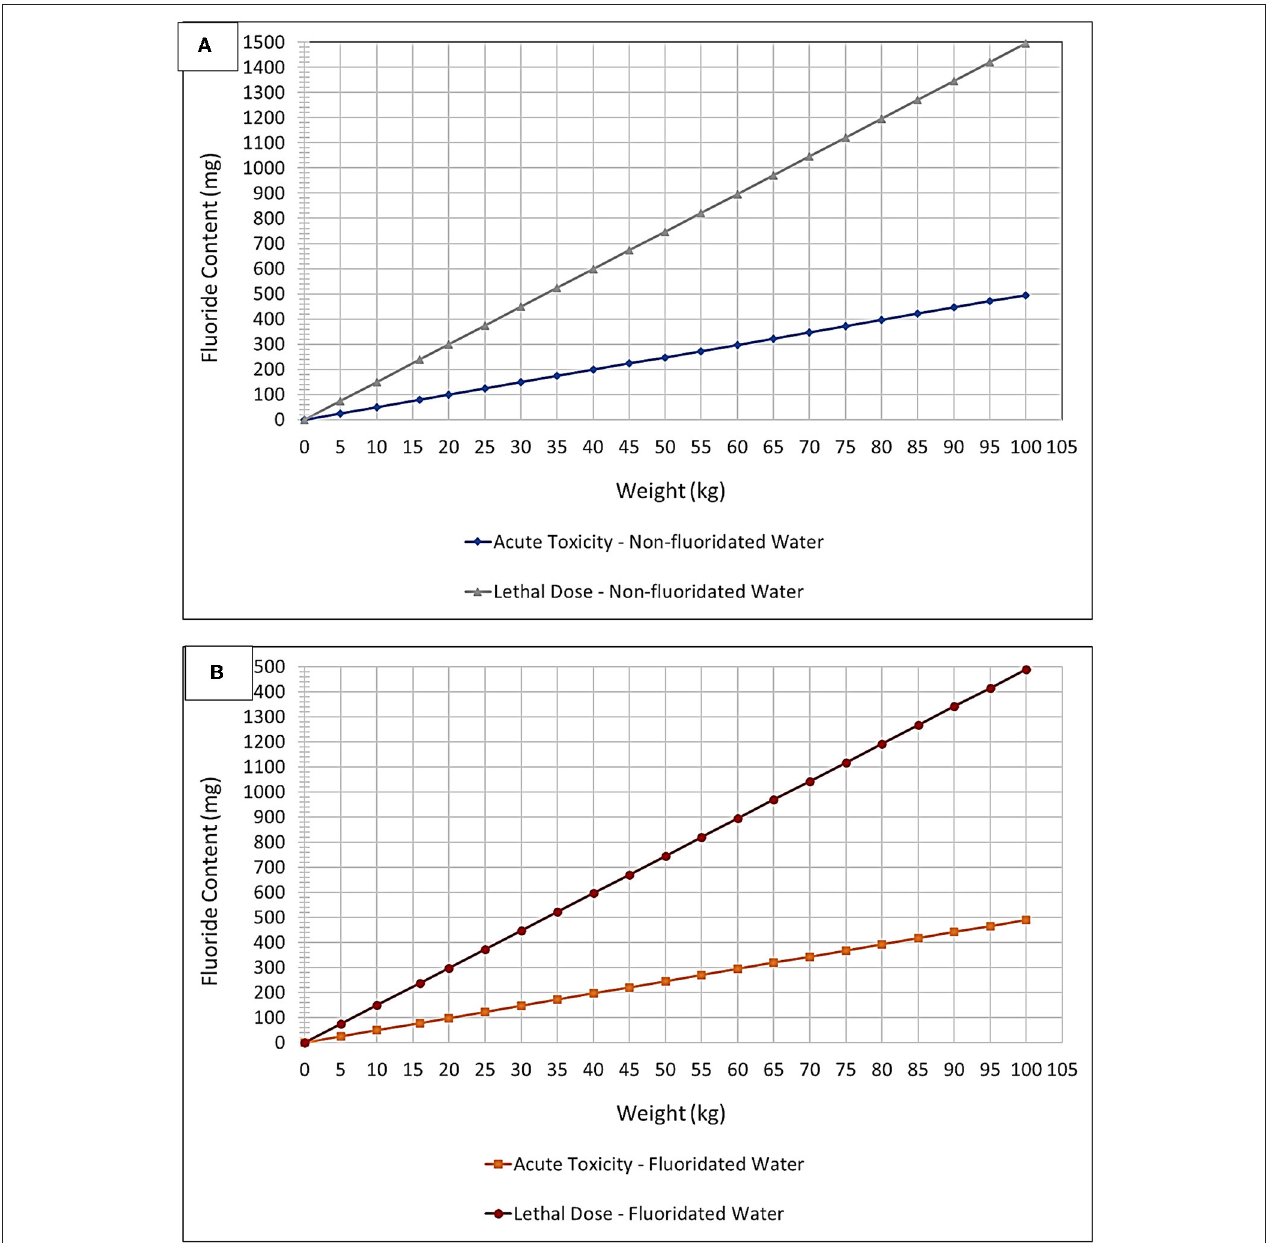
FIGURE 4 | “Plug and play” plot option – fluoride toxicity. Acute Fluoride Toxicity and CLD Thresholds expressed as a plot of mg of potential fluoride ingested vs. child body weight (kg) for (A) non-fluoridated and (B) fluoridated water environments. These thresholds were adjusted to account for fluoridated and non-fluoridated water environments, in addition to the ingestion of toothpaste up to an age of 6 years based on a mean weight of 16kg (lowest 3% body weight